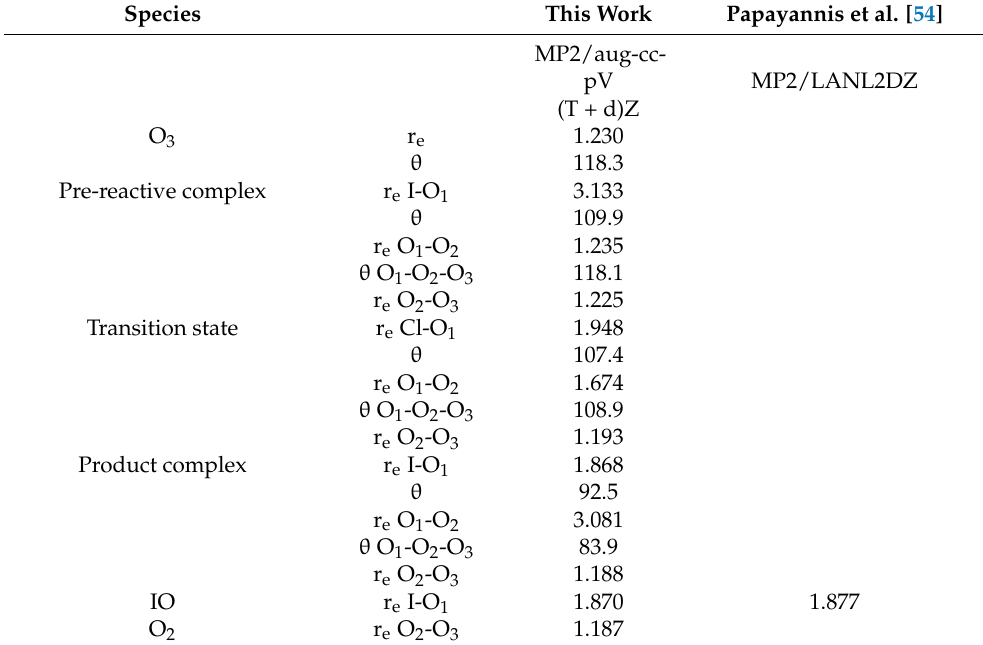
Table 7. The obtained bond lengths (r e in Å) and bond angles ( θ in deg) for the reaction of I + O 3 .